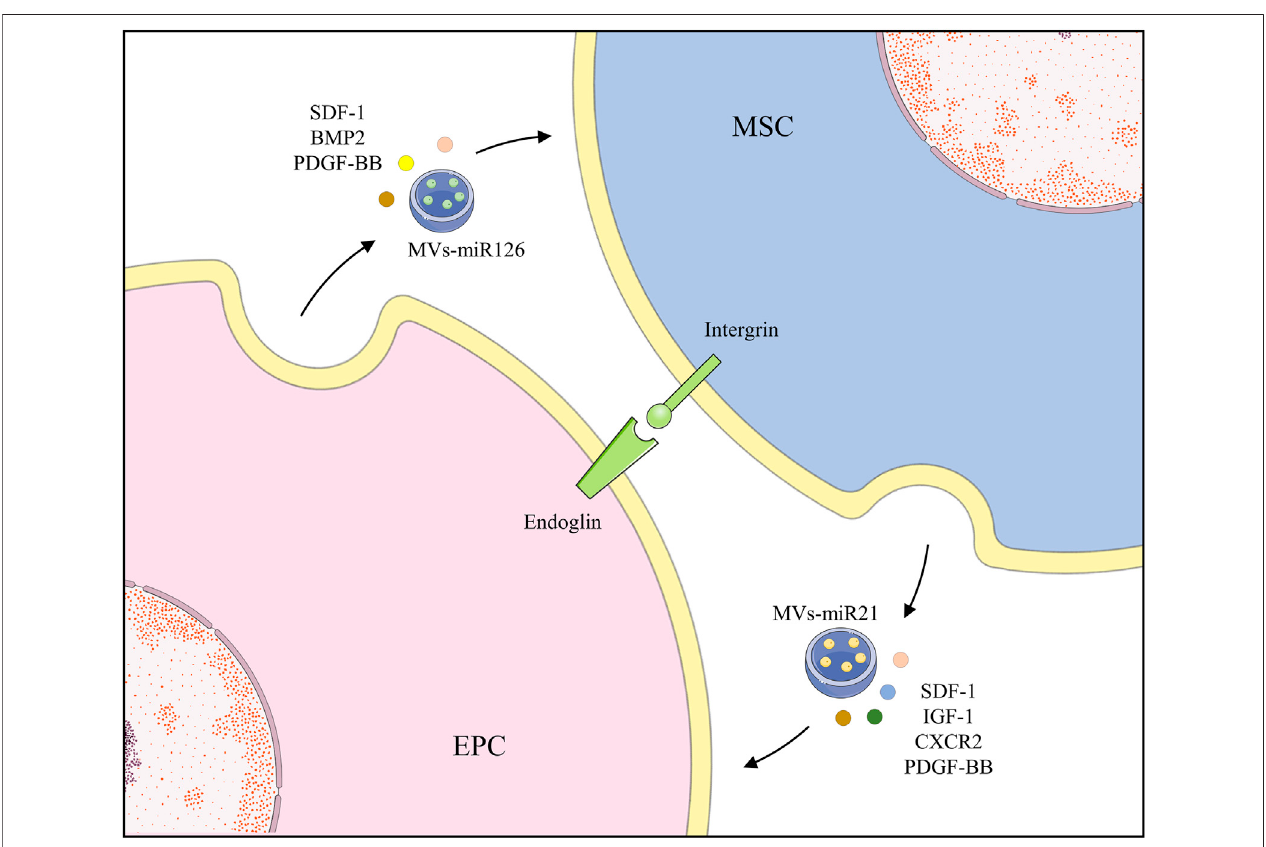
FIGURE 2 | EPCs and MSCs recognize and bind to each other through endoglin and secrete various growth factors and EVs to promote functions of each other.